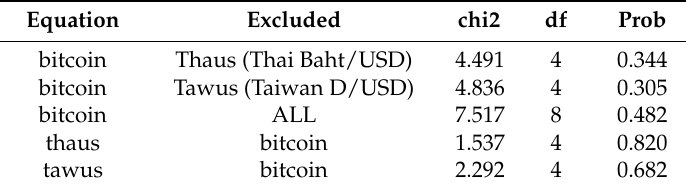
Table 6. Granger causality test for Bitcoin vs. relevant fiat currencies.